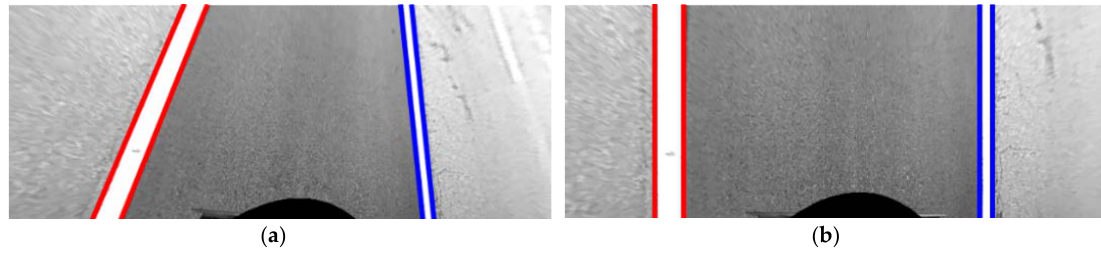
Figure 10. Images before and after the homography-based transformation. ( a ) Before the transformation; ( b ) After the transformation.